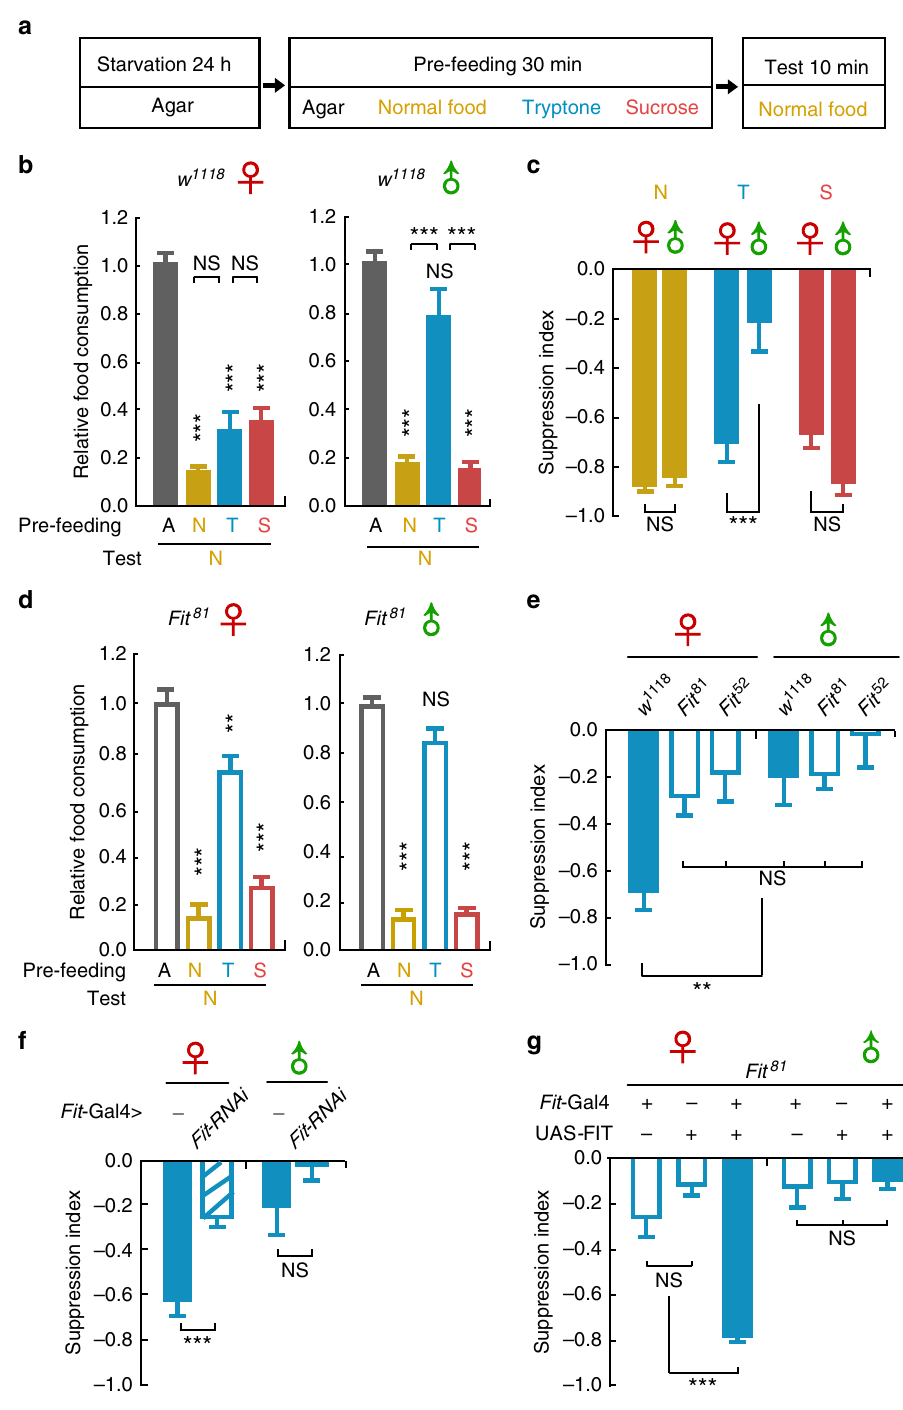
Figure 3 | Fit KO female flies exhibit deficiencies in protein feeding behaviour. ( a ) Diagram of the pre-feeding paradigm. ( b ) In WT flies, pre-feeding of normal food (N), tryptone (T) or sucrose (S) showed a suppressive effect on subsequent test feeding of normal food when compared with groups pre-fed with agar (A). Thus suppression was observed in both sexes, except that tryptone pre-feeding showed little effect on test feeding in male flies. n ¼ 8–12. One-way ANOVA, LSD’s post hoc test. ( c ) SI of tryptone were significantly different between WT female and male flies, while those of normal food or sucrose were comparable between sexes. n ¼ 8. P (Food*Sex) ¼ 8.17E-5 (two-way ANOVA, Bonferroni test). ( d ) Upon tryptone pre-feeding, Fit 81 mutant female flies exhibited food intake similar to that in male flies. n ¼ 8–13. One-way ANOVA, LSD’s post hoc test. ( e ) SI of tryptone in Fit KO females were significantly different from that in WT females, but were comparable to those in WTand KO males. All experiments in b – e have been performed in parallel. n ¼ 7–9. One-way ANOVA, LSD’s post hoc test. ( f ) The suppressive effect of tryptone pre-feeding was significantly reduced in flies with Fit knocked down in the FB. n ¼ 7–9. Data are analysed by unpaired Student’s t -test. ( g ) In Fit 81 mutant background, expressing FIT in the FB rescued the strong suppressive effect of tryptone pre-feeding in female flies. n ¼ 6–8. One-way ANOVA, LSD’s post hoc test. * P o 0.05; ** P o 0.01; *** P o 0.001. NS indicates no statistical significance. The data are mean ±